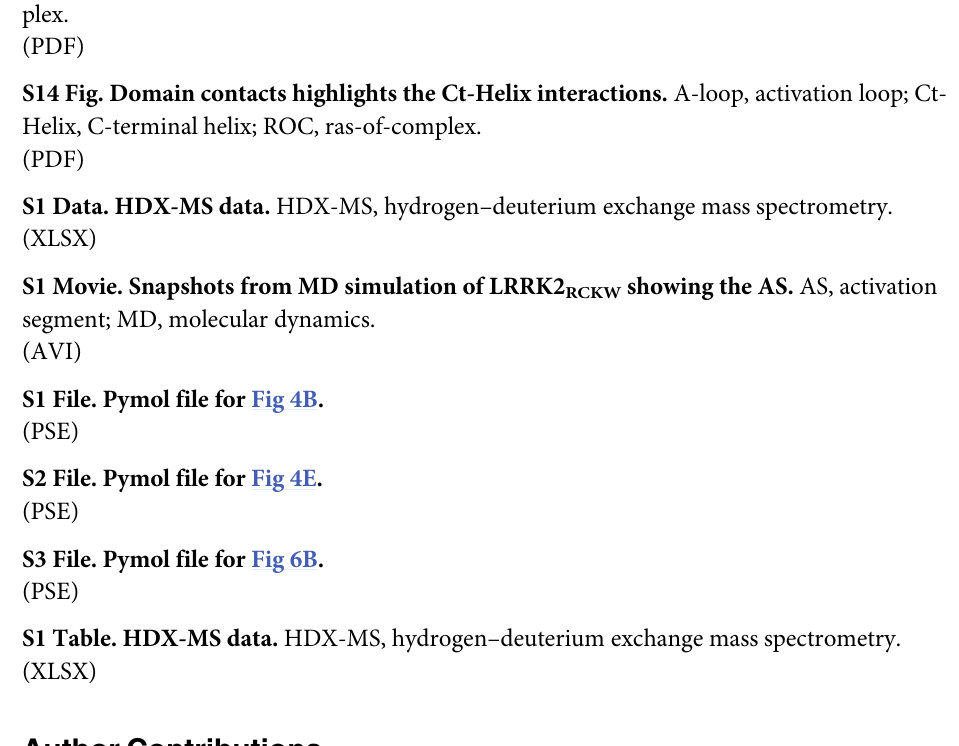
. Ct-Helix, C-terminal helix; ROC, ras-of-com- RCKW